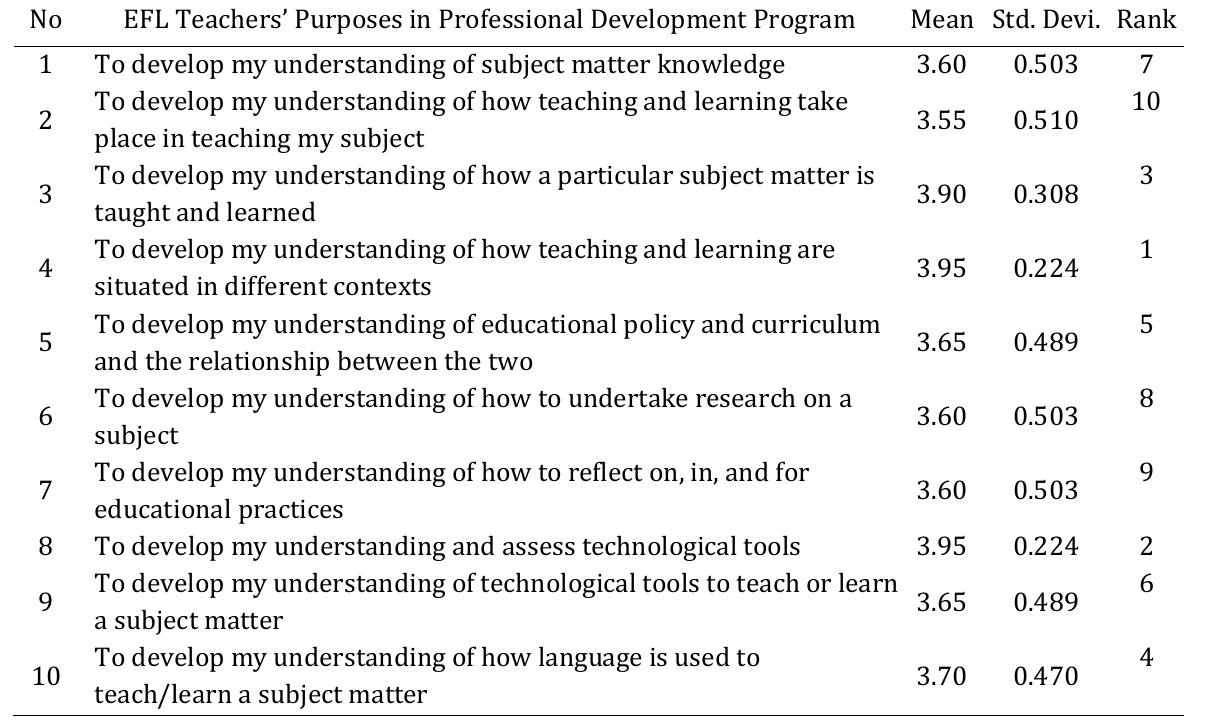
Table 4. EFL Teachers’ Purposes to Participate in the Professional Development